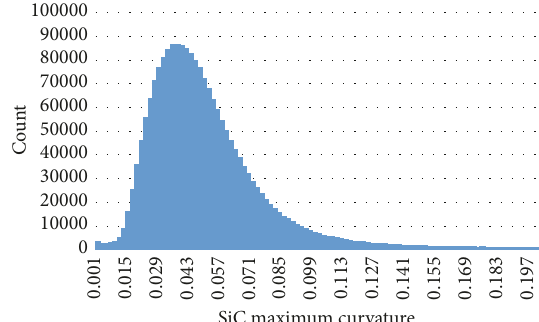
Figure 6: SiC maximum curvature